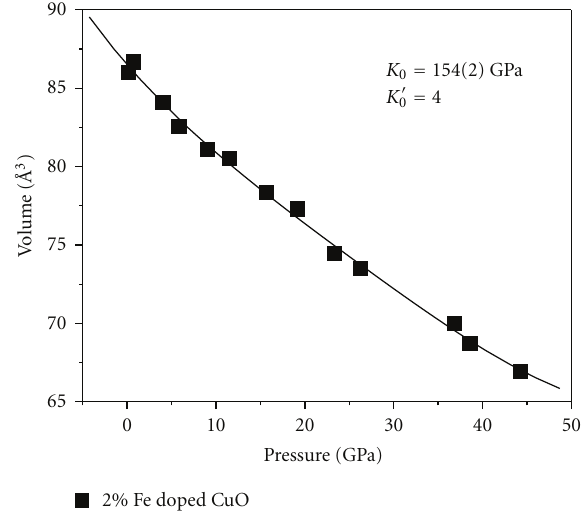
Figure 8: The 3rd-order BM-eos fit without any constraint onK (cid:5) 0 for the 2% Fe-doped bulk CuO sample. The error in the sample volume is equivalent to the size of the